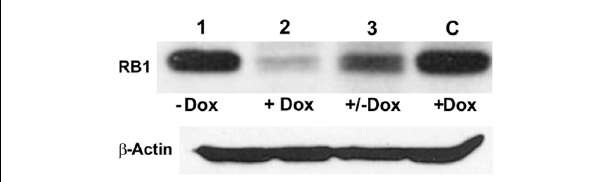
FIGURE 3 |TetO-driven, Dox-activated expression of the DN-CBRb transgene leads to downregulation of the endogenous RB1 in vitro . HEK293 cells, which endogenously express RB1 (Chano etal., 2006), were co-transfected with TetO-DN-CB-myc 6 -Rb1, and the pCMV-Tet3G transactivator vector. In the absence of Dox, co-transfected HEK293 cells stably expressed RB1 (lane 1). Addition of Dox to the system for a 24-h period led to TetO-DN-CB-myc 6 -Rb1 activation and RB1 downregulation (lane 2). Culturing a subset of those Dox-treated cells in a Dox-free media for an additional 24 h allowed for RB1 expression to be resumed (lane 3). C = Control HEK293 cells transfected with pCMV-Tet3G only, treated with